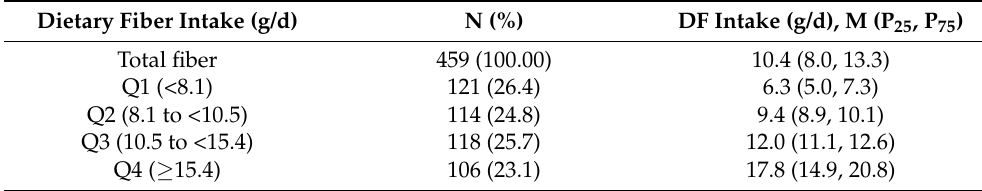
Table 2. The status of DF